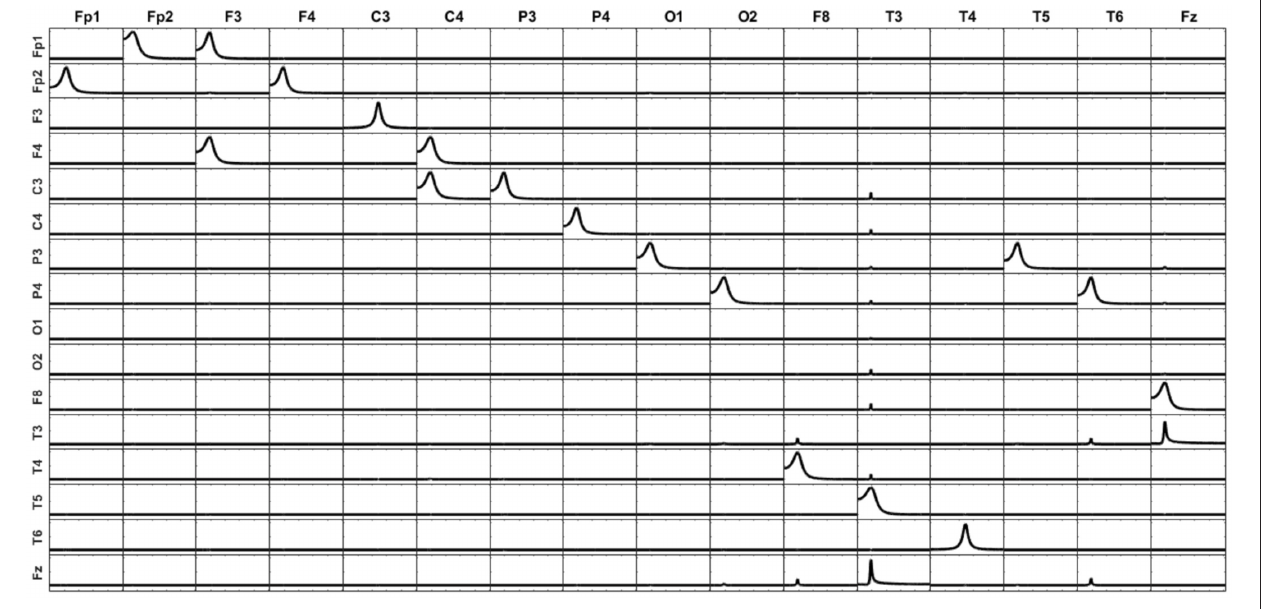
of time. The same procedure was used to assign the signal X2 of